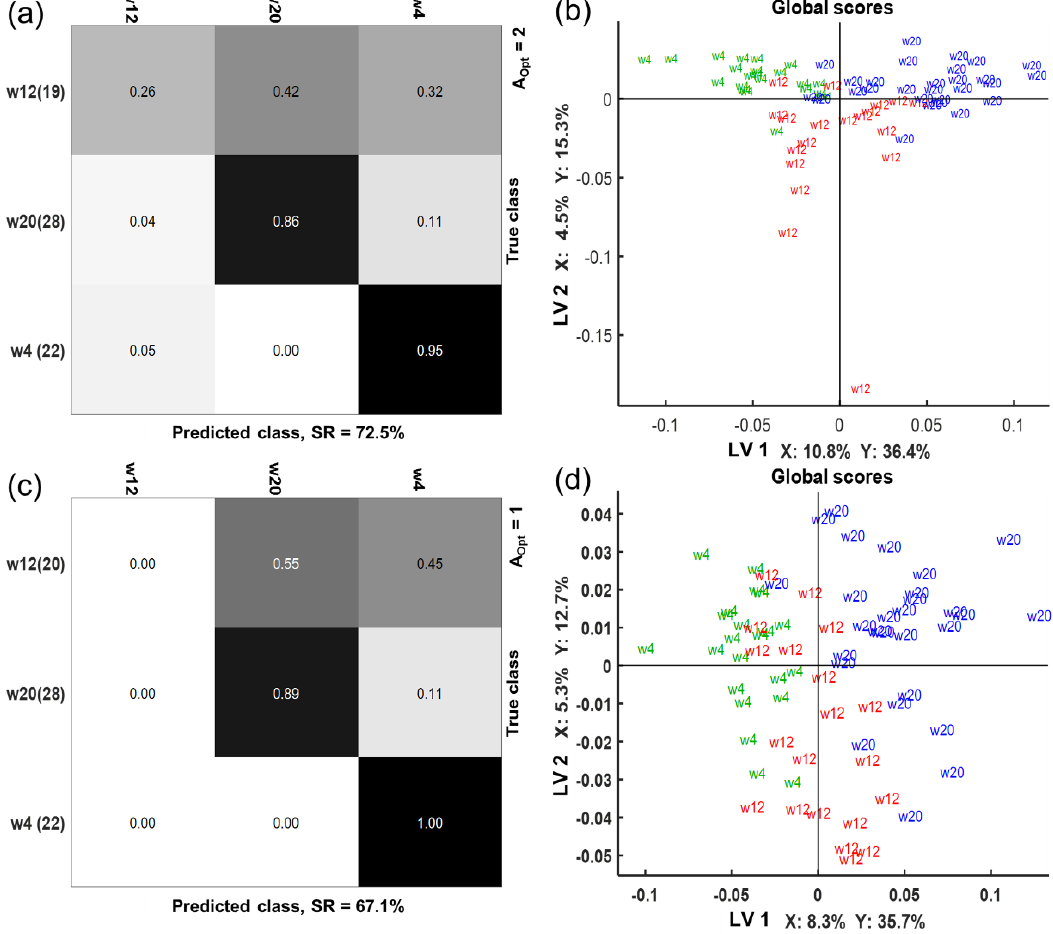
Figure 8. sMBPLSR confusion matrices ( a , c ) and global score plots ( b , d ) from time classification analysis using plasma, urine, and feces metabolomics in positive ( a , b ) and negative ( c , d ) ionization mode. The success rate (SR) of cross-validation is provided together with the number of latent variables of the models (A Opt ). Numbers in parentheses ( a , c ) reflect the number of samples used in the multi-block analysis after a sample-to-sample correspondence. Explained variances (%) in matrices X and Y by the corresponding latent variables (LV) are provided ( b , d ).